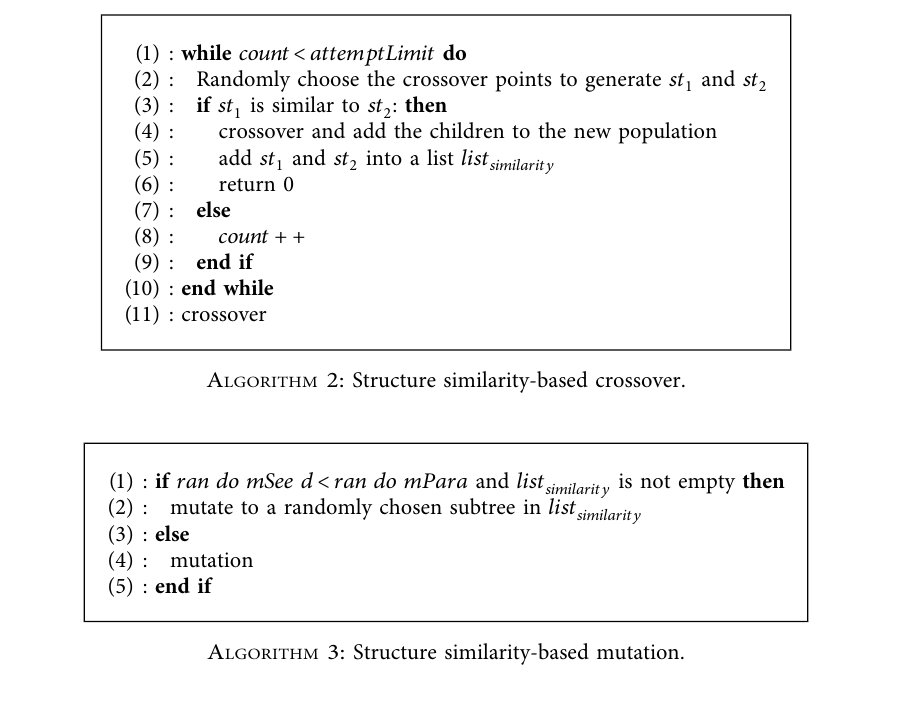
Table 2: Description of GP-SS and comparison algorithms.